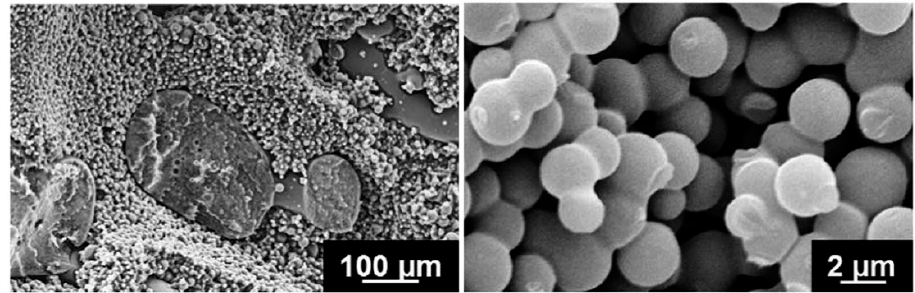
Figure 20. MTM57 50% SEM micrographs with a porous epoxy phase and connected spherical nodules from Shirshova et al. [79].